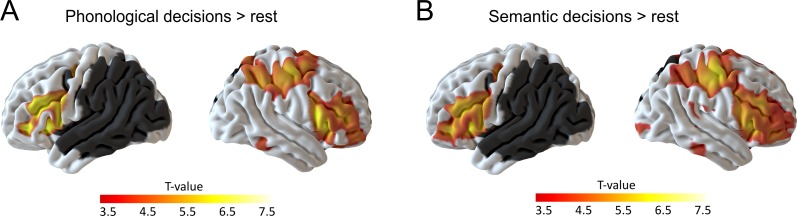
Residual language network after sham continuous theta burst stimulation.(A) Phonological decisions compared to rest and (B) semantic decisions compared to rest. Voxels with at least one lesion are masked in dark grey and were excluded from the analysis. Results are shown at p<0.001 uncorrected for display reasons.